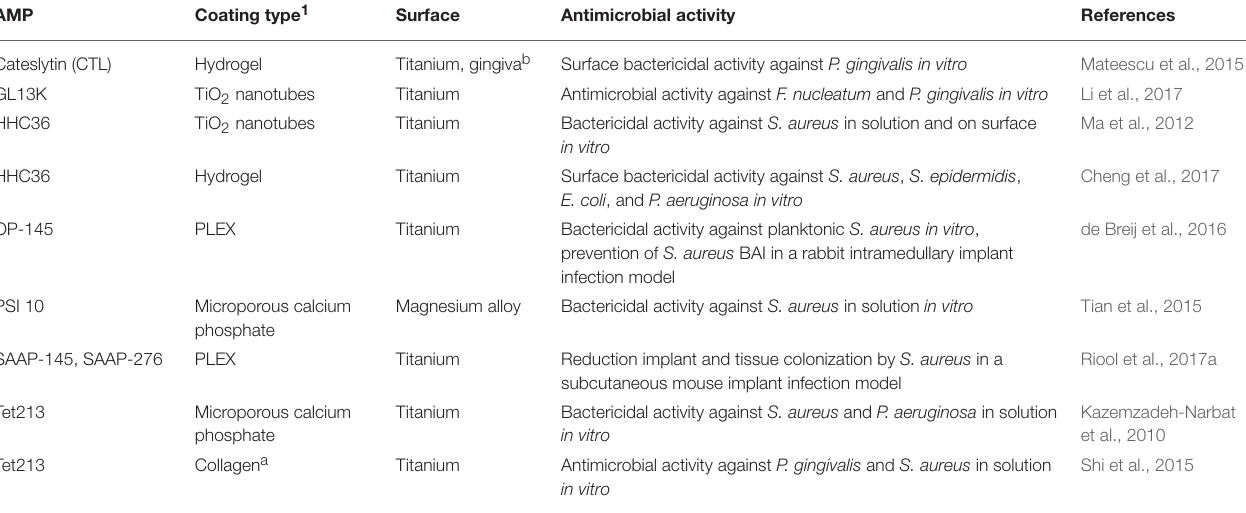
TABLE 2 | Overview AMP release